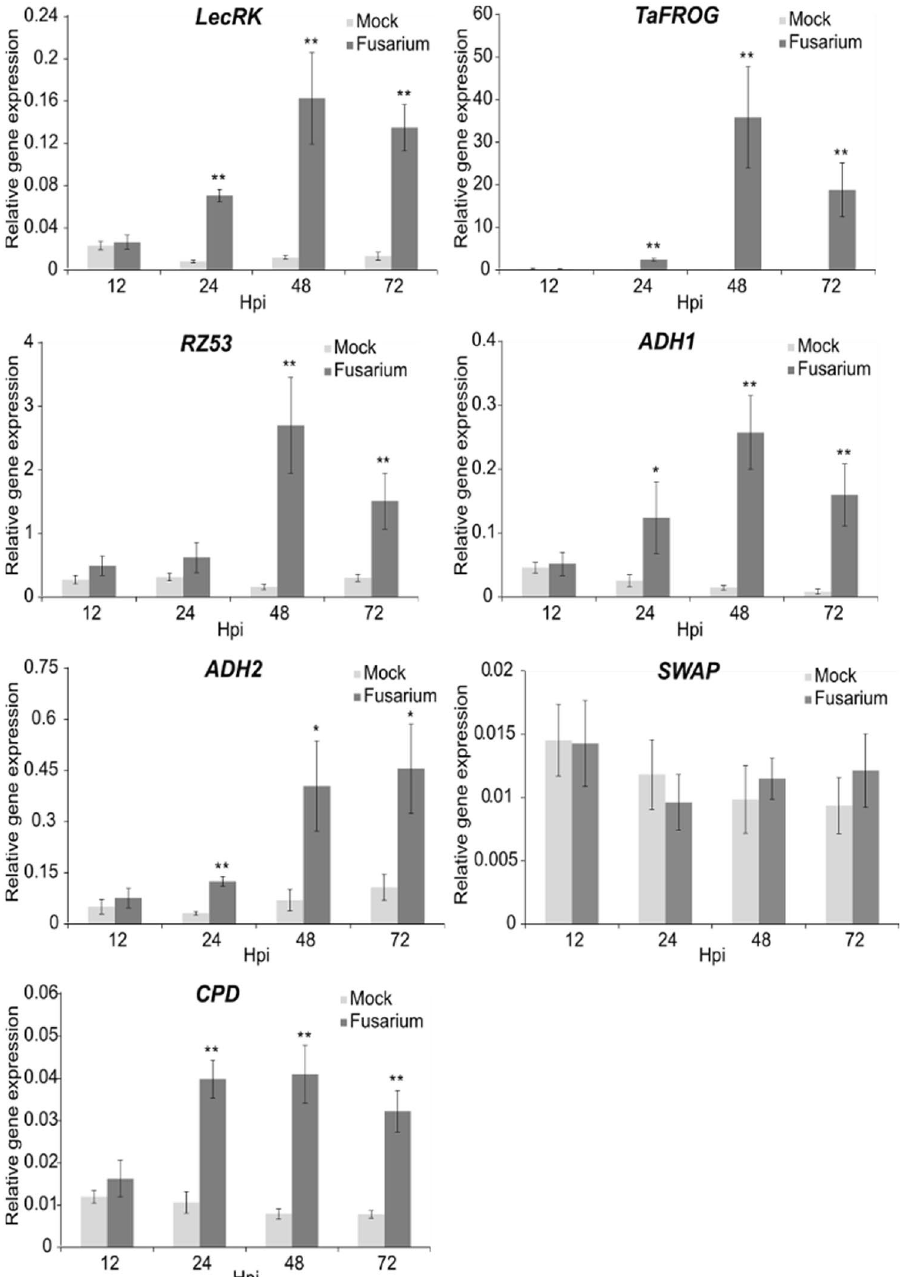
Figure 4. Expression profiles of Fusarium -responsive genes within the TaFROG cluster. Transcript levels in wheat (cv. CM-82036) heads after treatment with Fusarium graminearum was measured by qRT-PCR using the formula 2 −(Ct target gene—Ct average housekeeping genes) . Spikelets were harvested at various hours post-inoculation (hpi) as indicated. Results represent the mean of three independent trials (each include two technical replicates per treatment from a pooled of 4 biological sample) and error bars represent ± S.E.M. Asterisks show significant differences (* P < 0.05, ** P <